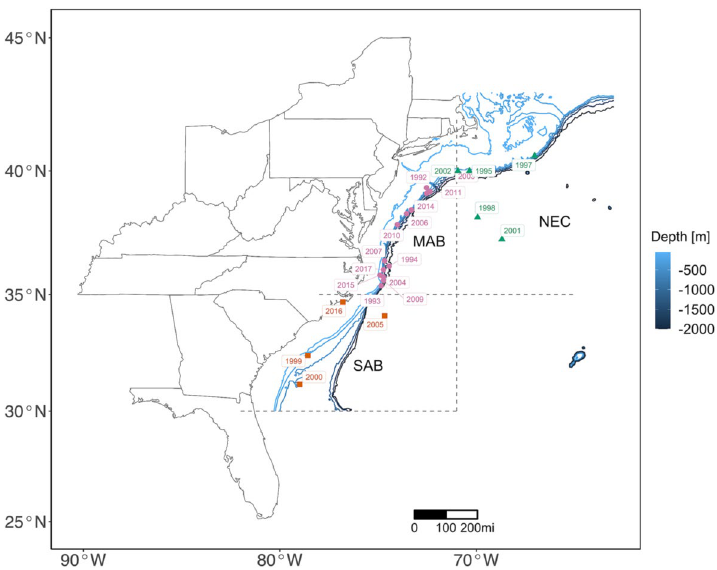
Figure 5. Annual seabird bycatch hotspot location from model T7 fitted to data from the three high-bycatch zones. Years with zero seabird caught (i.e. 1996, 2008, 2012 and 2013) are not shown. Hotspot locations in different fishing zones are displayed with different colors and shapes. Plot is made using R package ggplot2 (version 3.3.2, https:// ggplo t2. tidyv erse. org) in statistical program R (version 3.6.3, http:// www.R- proje ct. org/). Map data is from R package maps (version 3.3.0, https:// CRAN.R- proje ct. org/ packa ge= maps). Bathymetry data is from R package marmap (version 1.0.5, https:// github. com/ ericp ante/